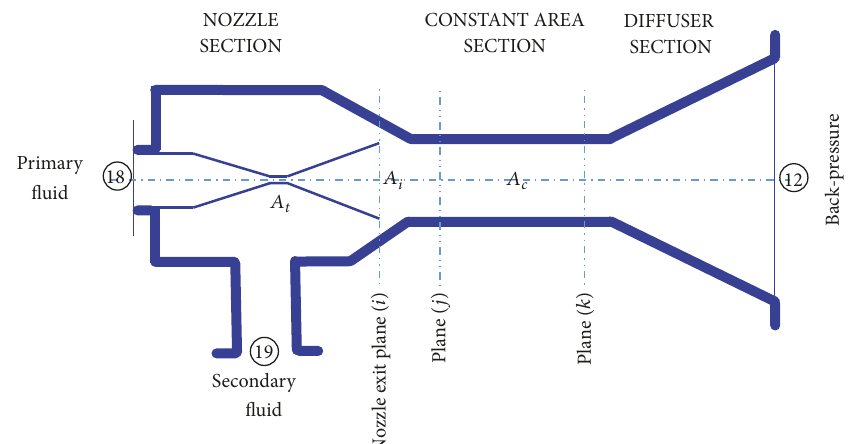
Figure 2: Ejector